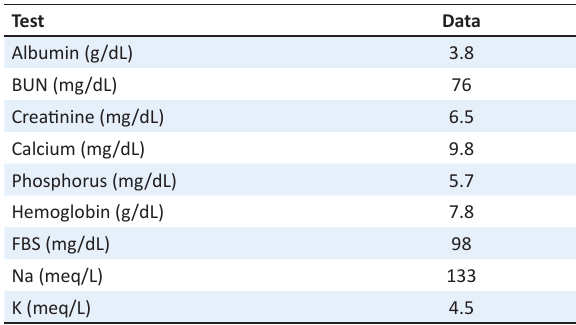
Table 4. Laboratory data at the time of discharging of the patient with multiple myeloma and acute renal